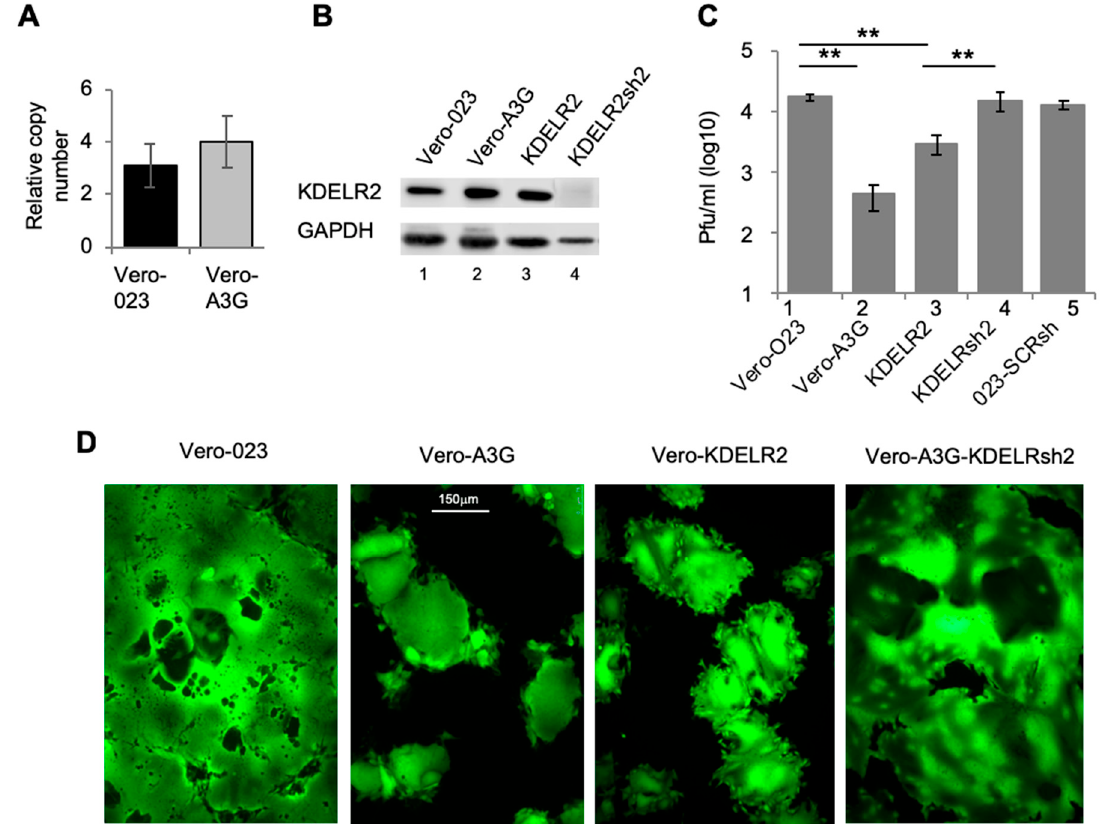
Figure 1. The A3G upregulated gene KDELR2 reduces MV replication in Vero cells. ( A ) Total RNA from Vero 023 and Vero A3G was isolated and reverse transcribed into cDNA. KDELR2-specific cDNA was then amplified using SYBR-Green Real-Time qPCR ( n = 3). ( B ) The protein expression of KDELR2 was analyzed using Western blot. Equal amounts of cell lysates were separated on 12% SDS-PAGE and transferred on a nitrocellulose (NC) membrane. Target proteins were probed with primary KDELR2 antibody and HRP conjugated secondary antibody then developed using ECL (lane 1: Vero 023, lane 2: Vero A3G, lane 3: Vero KDELR2, lane 4: Vero A3G + KDELR2shRNA). ( C ) Transduced Vero cells were infected with MV eGFP at MOI of 0.1. The titer of newly synthesized virus in these cells was determined 48 h post infection on Vero cells ( n = 3). Significance was calculated using the Student’s t test (** p < 0.01). ( D ) Representative micrograph of MV syncytium based on eGFP fluorescence 72 h post infection (magnification × 100, size bar: 150 µ